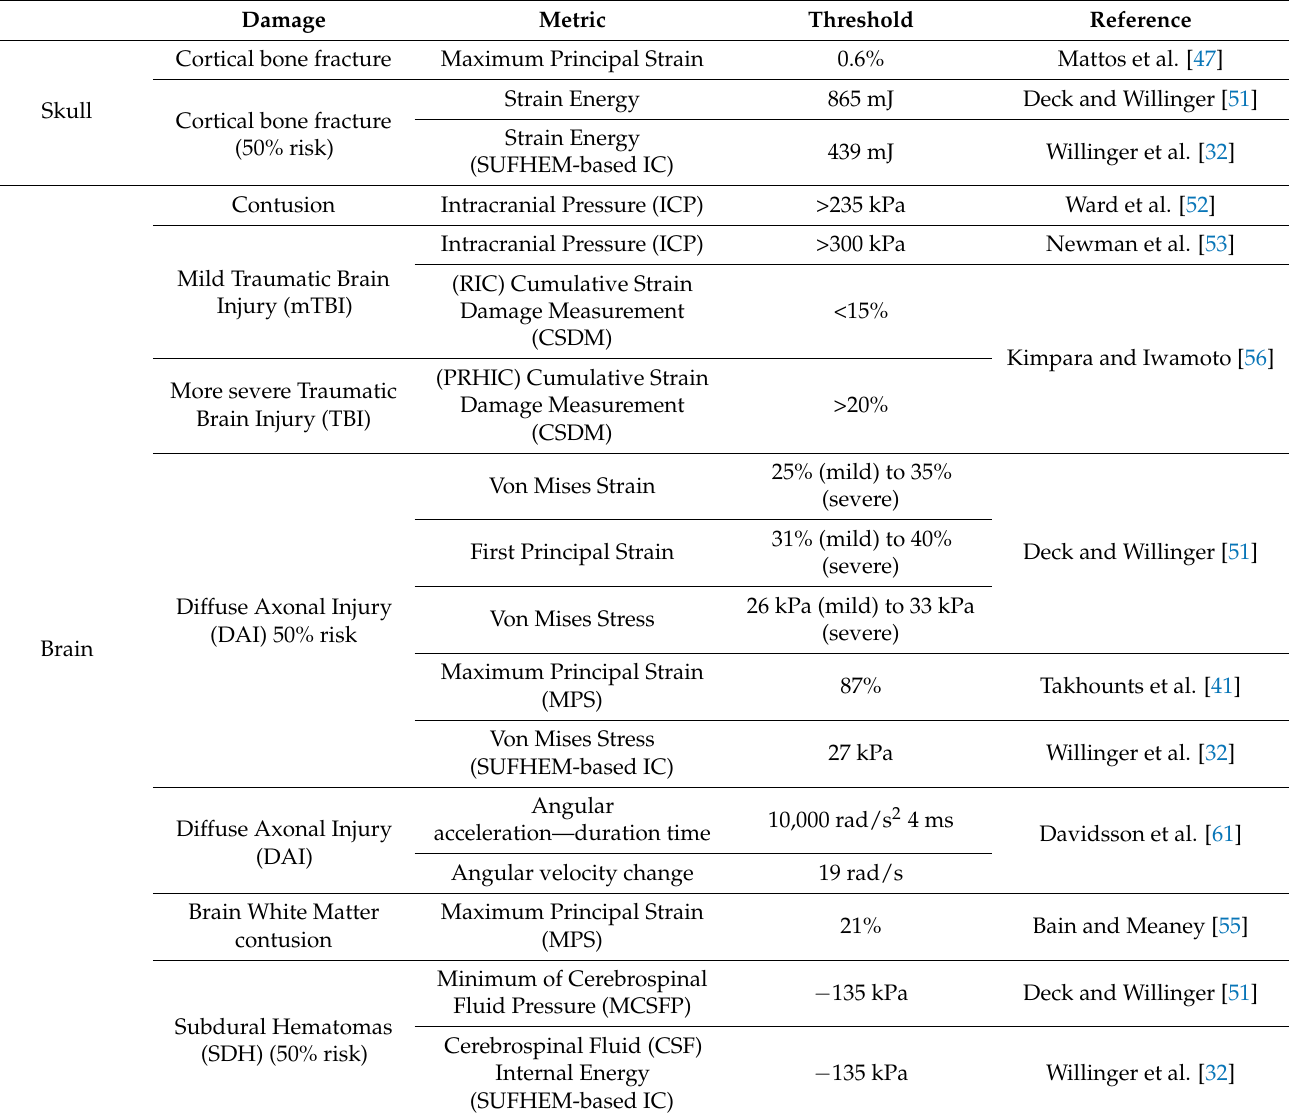
Table 1. Summary of the main IC proposed for the head and the